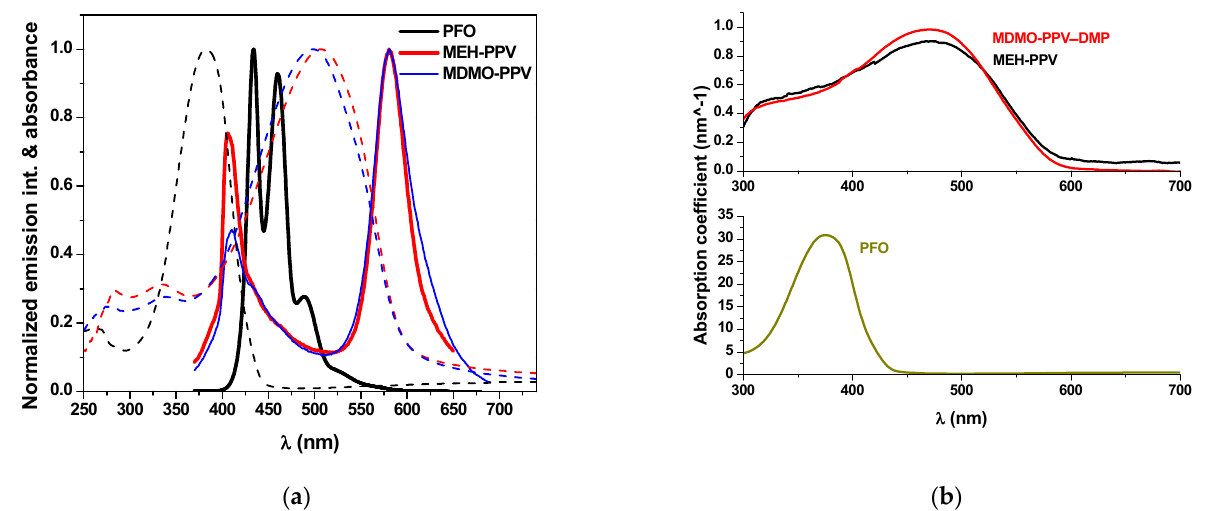
Figure 2. ( a ) Normalized absorbance (dash curves) and emission spectra (solid curves) of the pristine PFO (black colors), MEH-PPV (red colors) and MDMO-PPV–DMP (blue colors) thin films. ( b ) Absorption coefficient of pristine polymer thin films.